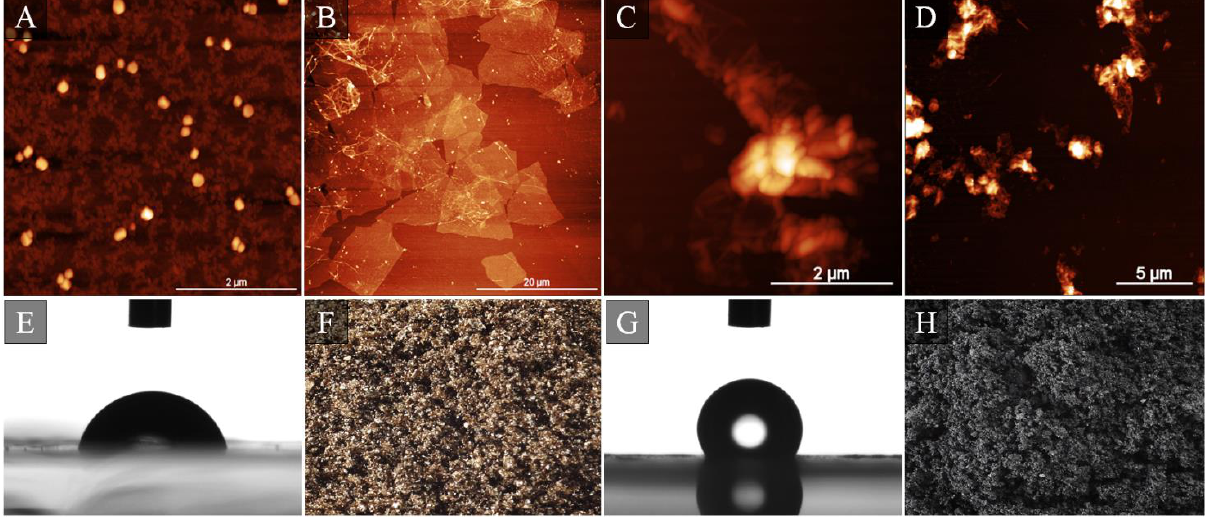
Figure 4. Representative atomic force microscopy images of GO nano- ( A ) and micrometric ( B ) flakes along with RGO flakes ( C , D ). Images ( E , G ) present water contact angle results acquired for hydrophilic GO and hydrophobic RGO followed by optical images of GO ( F ) and RGO ( H ) powder. Image composed with Authors’ own and previously not published data.